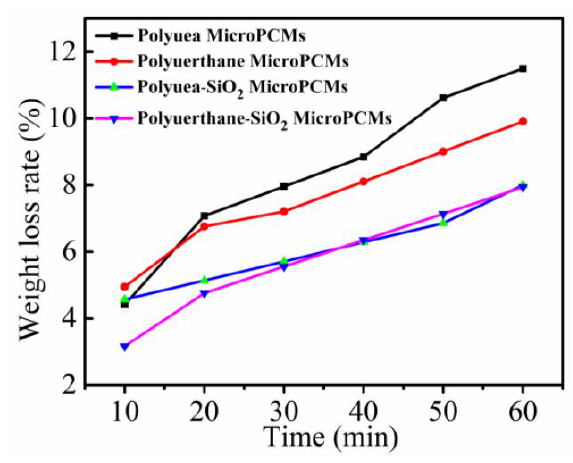
Figure 8. Weight loss rates curve comparison of various MicroPCMs.